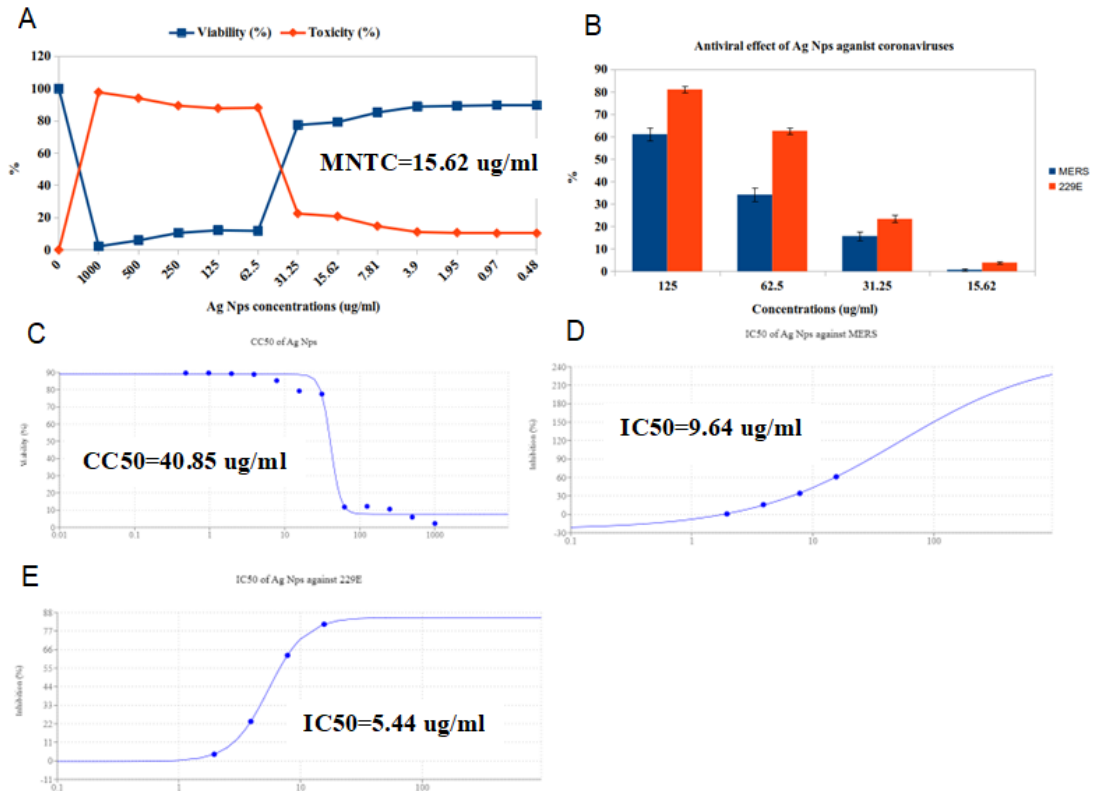
Figure 12. Anti–coronavirus activity of free silver nanoparticles (Ag NPs) against MERS and 229E viruses using the Vero cell line. ( A ) cytotoxicity; ( B ) antiviral activity; ( C ) CC50; ( D ) IC50 of the extract against MERS; ( E ) IC50 of the extract against 229E.